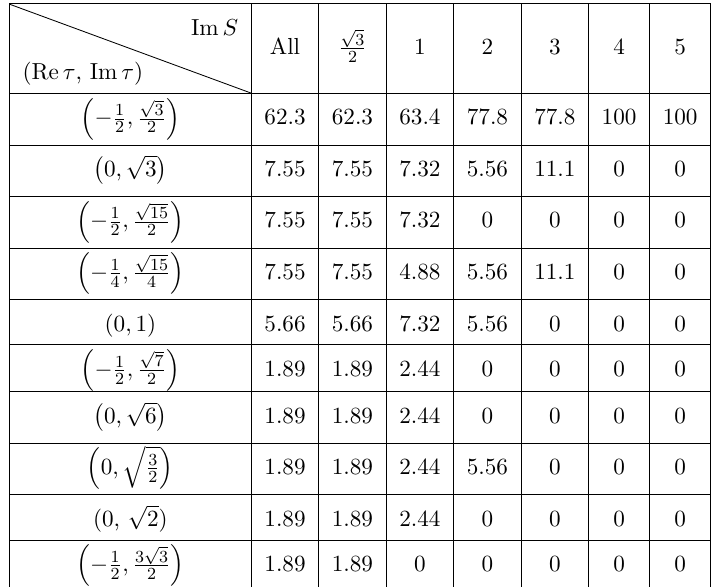
Table 5 . Probabilities (%) of the stable vacua as functions of (Re (cid:28); Im (cid:28) ) and Im S in the descending order of the probability with respect to (Re (cid:28); Im (cid:28) ). Here, we list the probability for N max and the column in \All" corresponds to the probability of table 2.